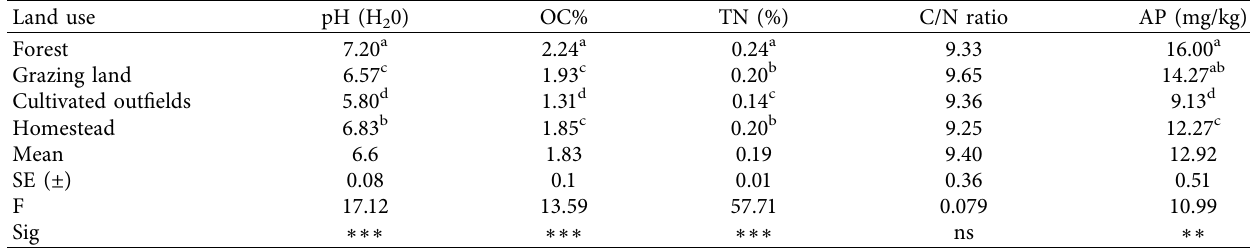
Table 4: Mean values of the selected chemical properties of soils as affected by land uses. Land use